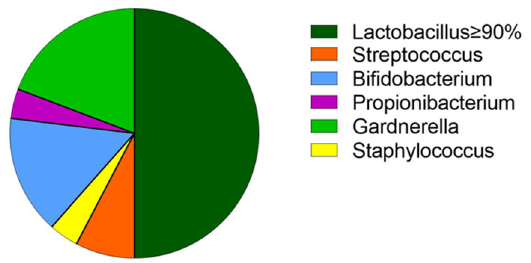
Table 3. Descriptive statistics of microbial parameters for the two study groups. The data are ex- pressed as mean ± SD. Statistical analysis was performed by unpaired t-test. **** p < 0.0001 vs. eu- biosis patients.